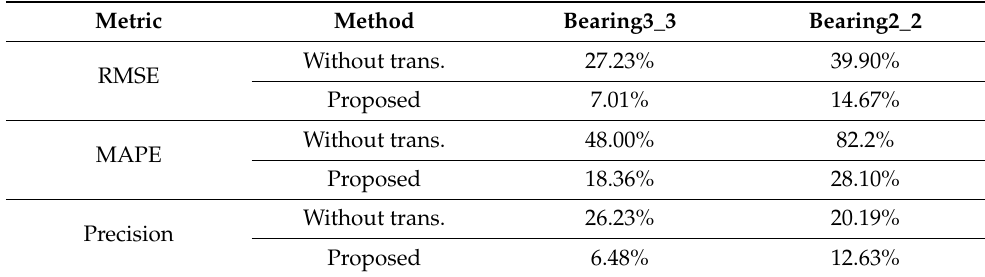
Table 3. Prediction metric results